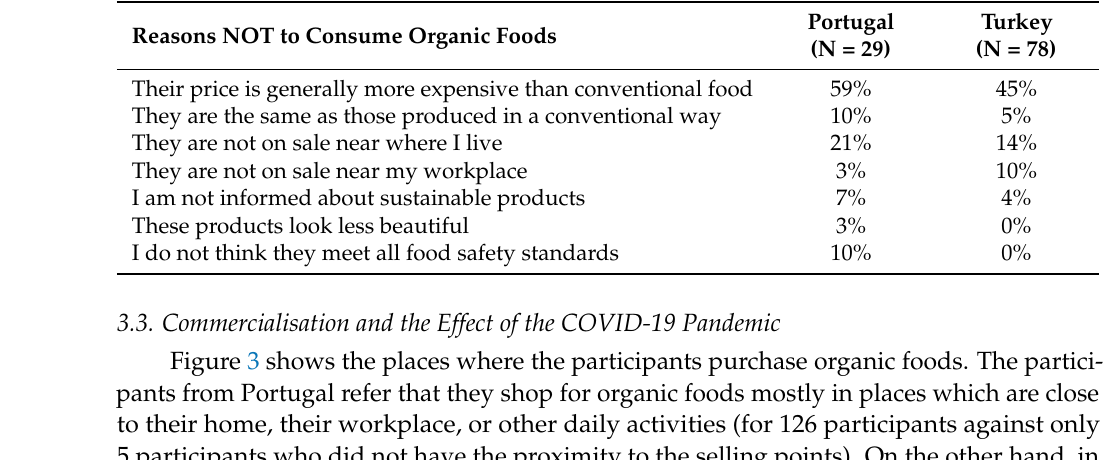
Table 5. Monthly household income of the